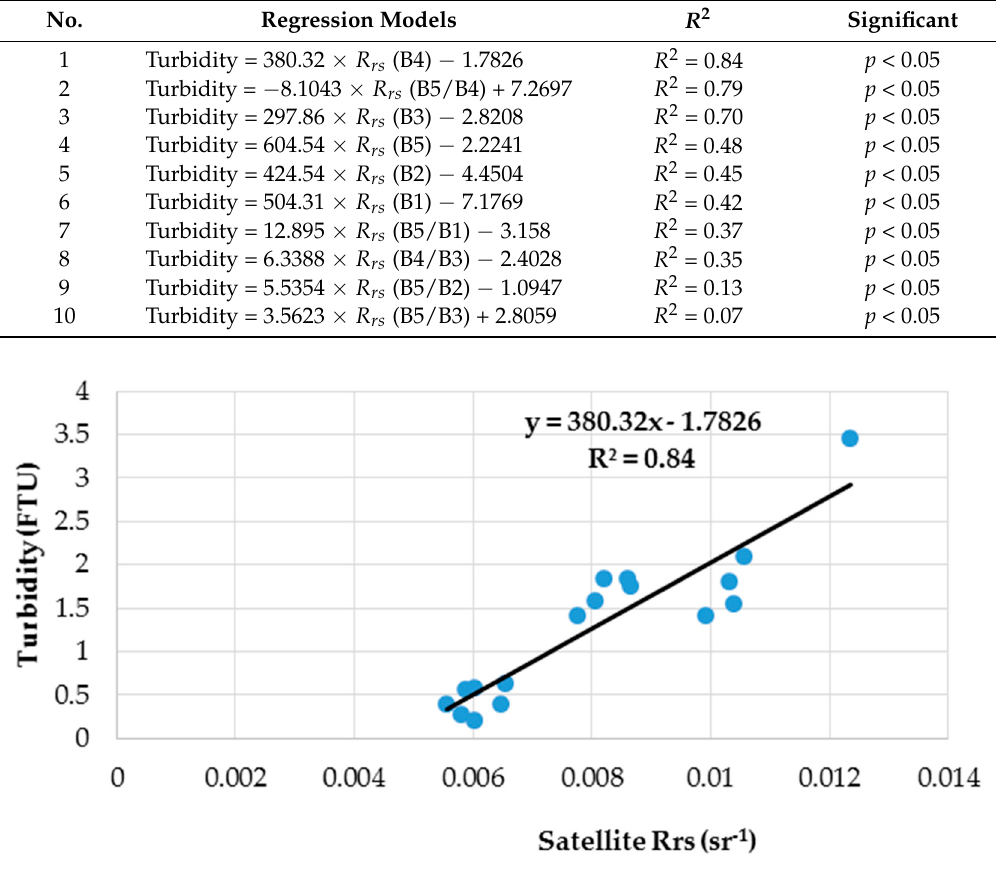
Figure 3. Correlation between remote sensing reflectance at 655 nm extracted from Landsat 8 OLI on 14 February 2016 and turbidity from in situ by using AAQ sensor.